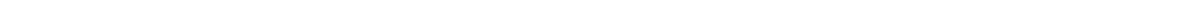
Fig. 1 CDYL protein is downregulated by neuronal activity in vivo. a Illustration of the stimulatory hM3Dq DREADD system. A schematic diagram showed the stimulatory hM3Dq DREADD that is activated by clozapine-N-oxide (CNO). b Western blot analysis of indicated proteins in hippocampus tissues obtained from mice injected vehicle or CNO for 5 days ( n = 4 mice in each group). c Quanti fi cation of the western blotting in b by normalizing the levels of the indicated proteins to that of β -actin. n = 4, * p < 0.05, ** p < 0.01, paired two-tailed Student ’ s t -test. Data were represented as mean ± s.e.m. d Immunohistochemistry (IHC) images showing the expression of CDYL protein in DG, CA1, striatum and neocortex area of the rat brain. Scale bar , 5 mm ( left ), 0.2 mm ( right ). e Western blotting and quanti fi cation showing CDYL protein was decreased upon exposure of rats to enriched enviroment (EE). n = 5, * p < 0.05, paired two-tailed Student ’ s t -test. f Western blotting and quanti fi cation showing intracranial injection of NMDA (10 μ M) into rat hippocampus DG area signi fi cantly decreased CDYL protein level. n = 4,* p < 0.05, paired two-tailed Student ’ s t -test. g Western blotting and quanti fi cation showing CDYL expression levels were gradually reduced after status epilepticus in rat temporal lobe epilepsy model. n = 3, ** p < 0.01, *** p < 0.001, one-way ANOVA with Bonferroni ’ s multiple-comparisons test. Data marked asterisks in the fi gure are signi fi cantly different from control. h IHC results showing CDYL protein was decreased in the 28 days after status epilepticus in rat temporal lobe epilepsy model ( left ). Scale bar , 0.1 mm ( upper ), 0.2 mm ( bottom ). The reduction of CDYL expression was con fi rmed by western blotting and quanti fi cation ( right ). n = 3, ** p < 0.01, paired two-tailed Student ’ s t -test. Data were represented as mean ±